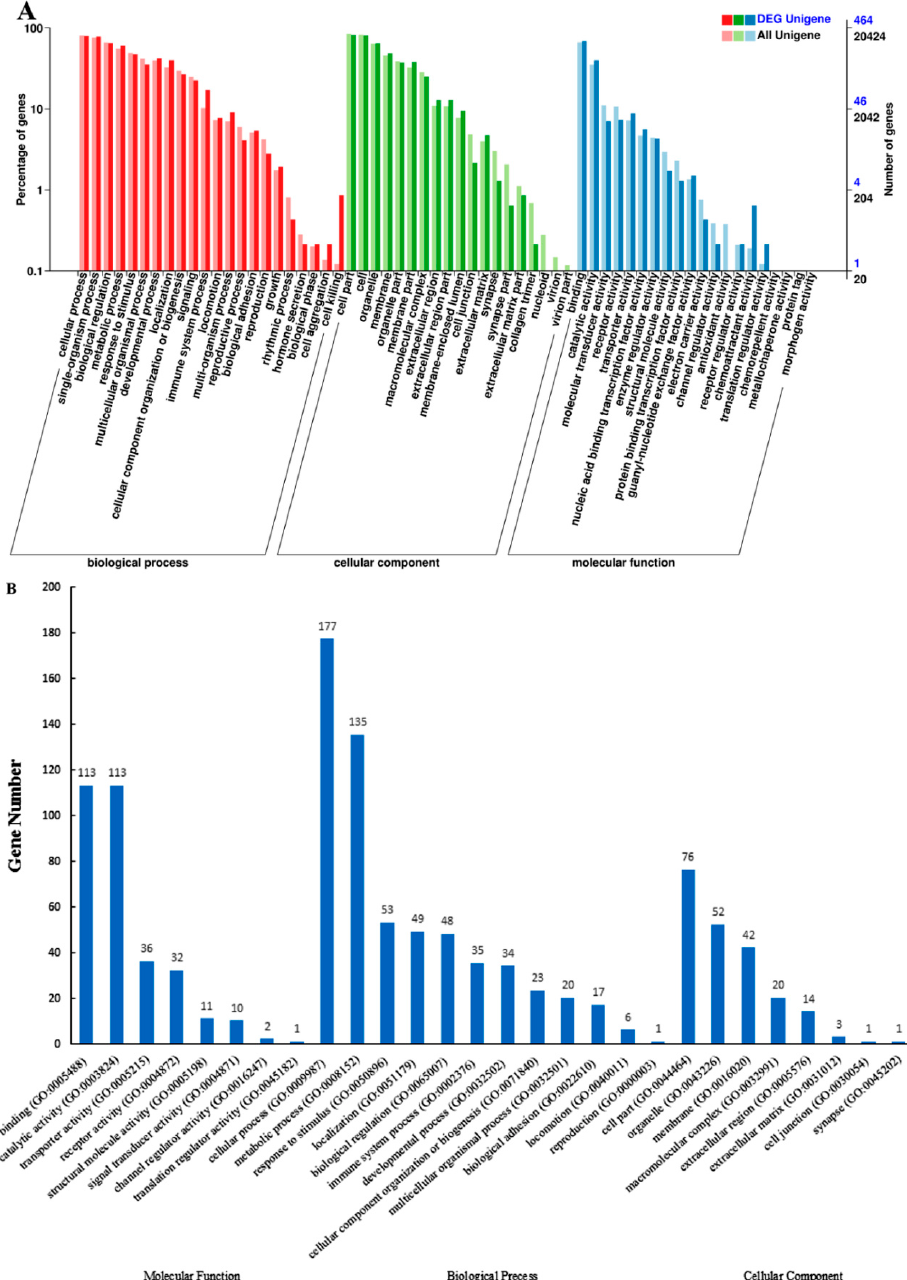
Figure 3. GO classification of the differentially expressed mRNAs and predicted target mRNAs of differentially expressed miRNAs in fresh and frozen ‐ thawed boar sperm. ( A ) Differentially expressed mRNAs. The horizontal coordinate represents the GO classification, the left side of the vertical coordinate represents the percentage of genes, and the right side is number of genes; ( B ) predicted target mRNAs of differentially expressed miRNAs. The horizontal coordinate represents the GO classification; the vertical coordinate is the number of genes.